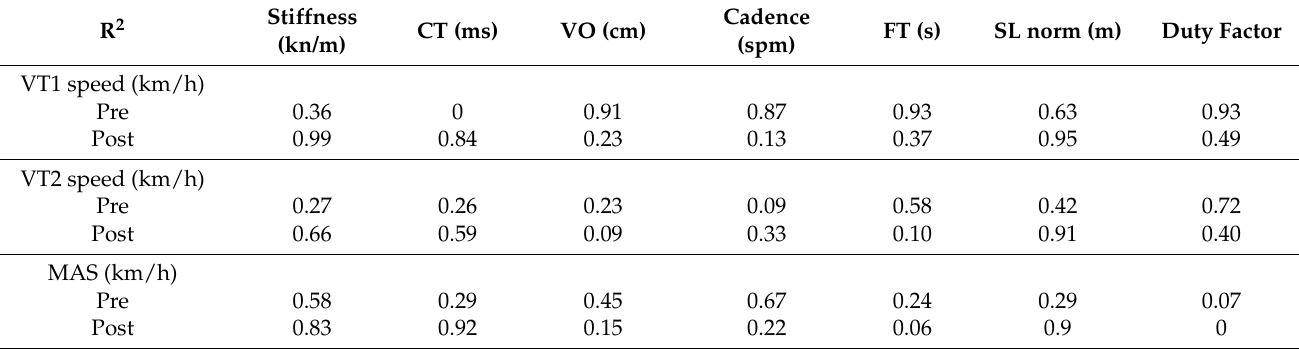
Figure 2. Evolution of the contact time, flight time and duty factor, as the test speed increases in the selected sample (n = 4 elite triathletes) in ventilatory thresholds 1 (VT1) and 2 (VT2) and maximal aerobic speed (MAS). Table 4. Contribution of the biomechanical parameters to the performance at different speeds. R